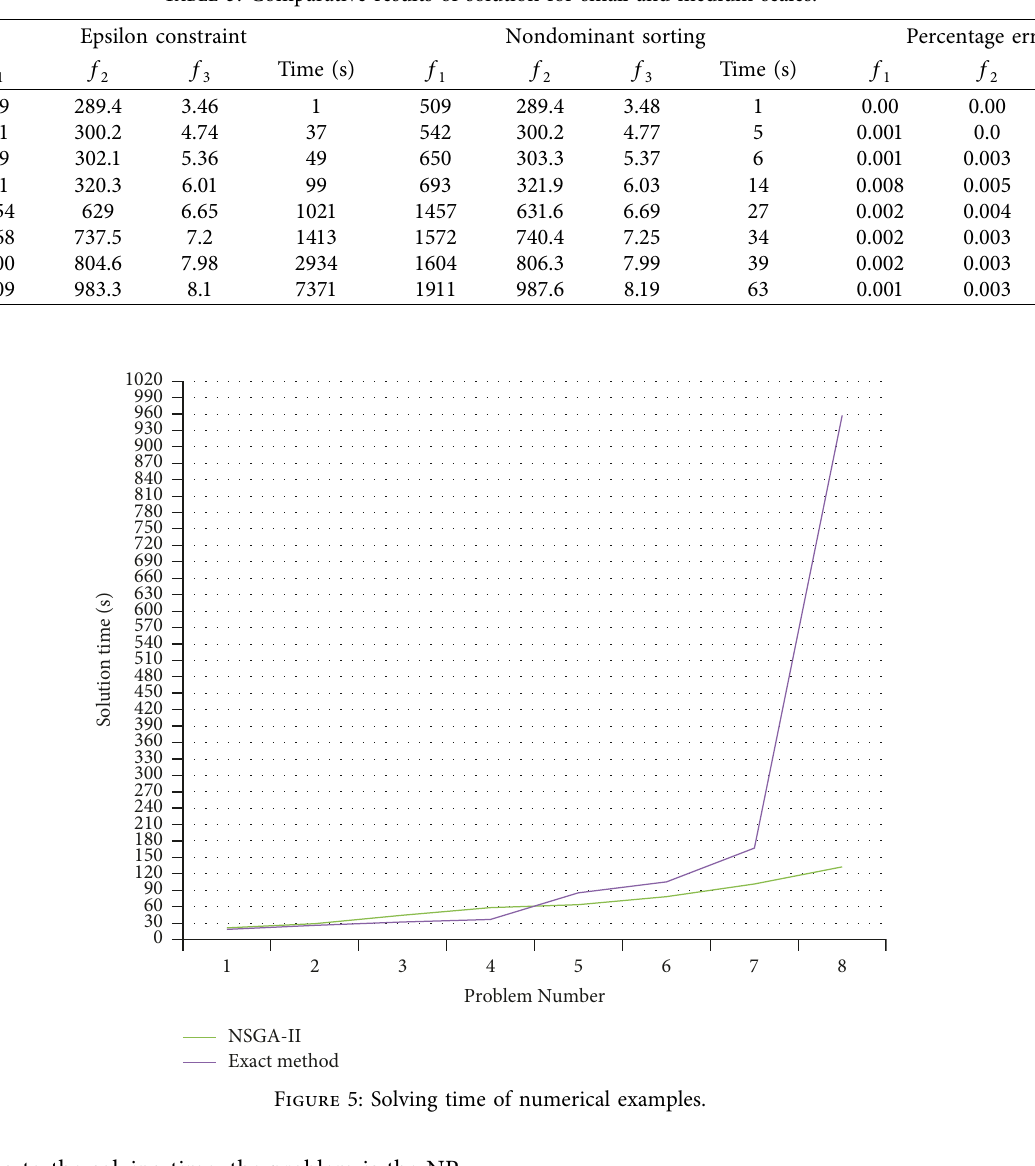
Table 6: Capacity